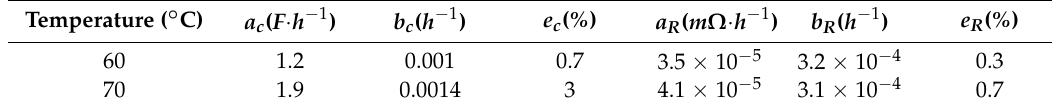
Table 1. Identified parameters of the Langmuir model at 60 ◦ C and 70 ◦ C.